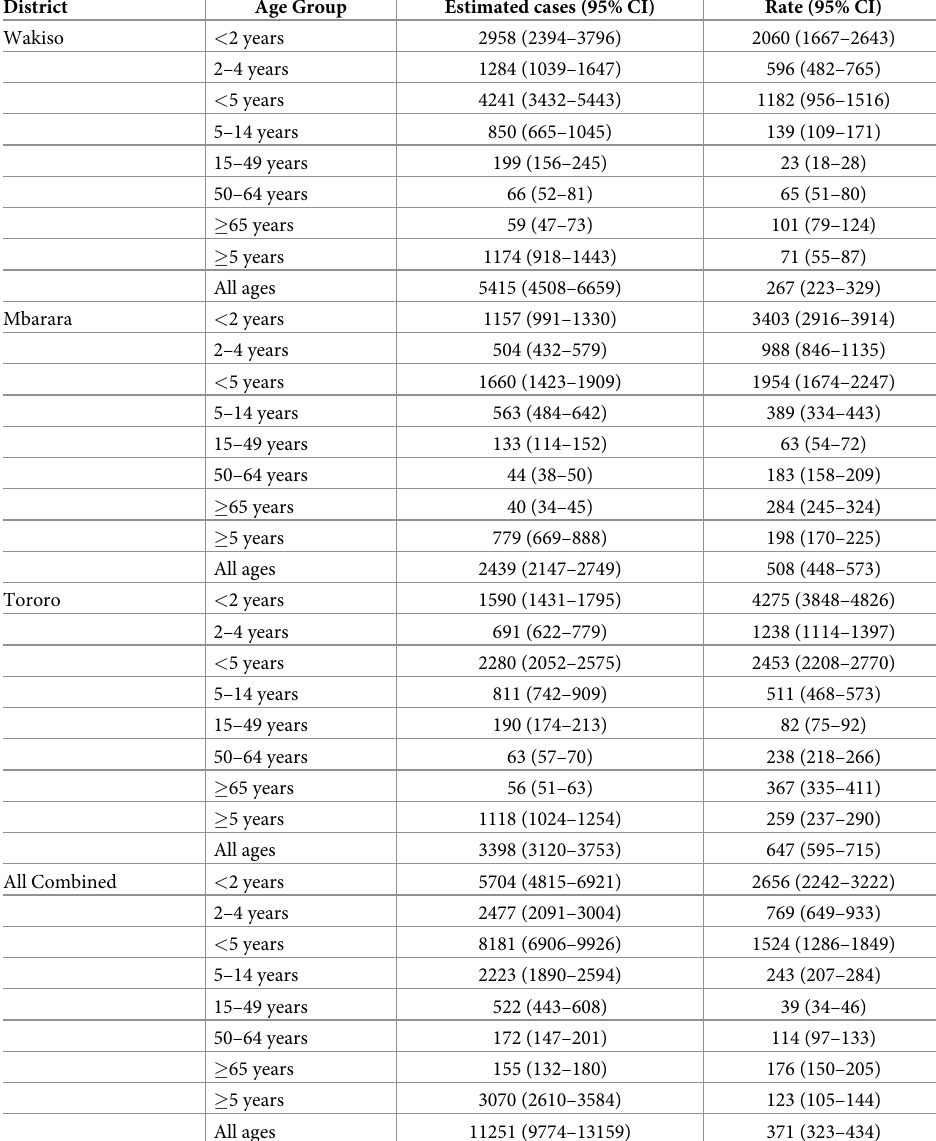
Table 3. Estimated mean annual age-specific number and rate (per 100,000 persons) of pneumonia hospitaliza- tions in three districts in Uganda, 2013–2016.